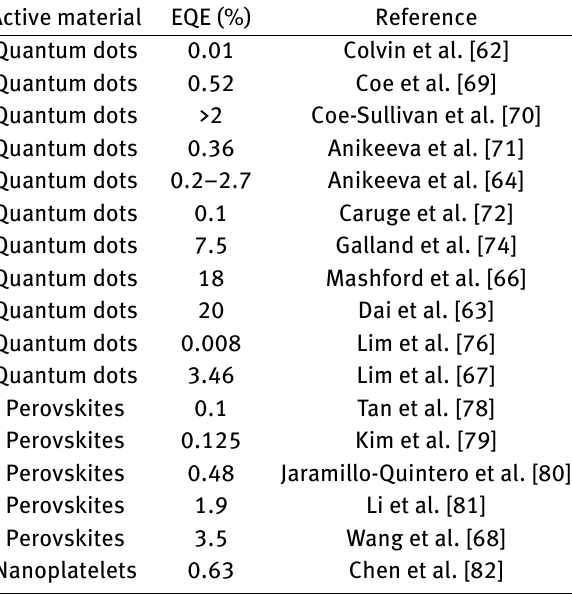
Table 2: Summary of the external quantum eflciency (EQE) belong- ing to the electroluminescent light-emitting diodes (LEDs) covered in this